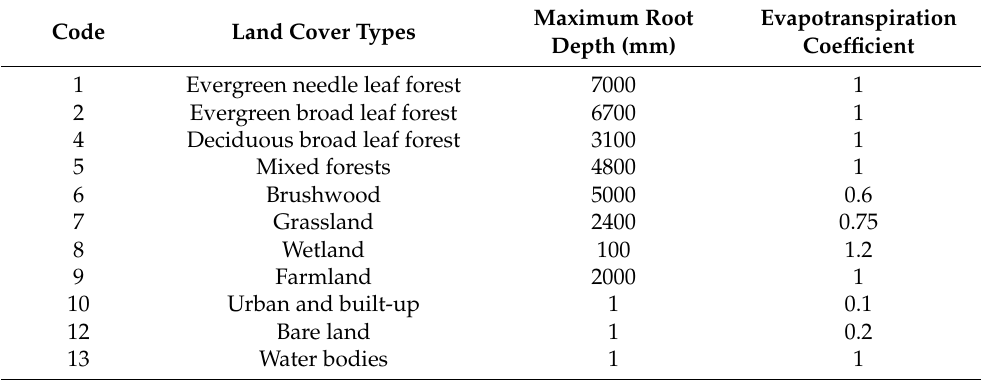
Table 3. Maximum root depth and evapotranspiration coefficient of different land use/cover types in the Dongjiang Lake Basin.